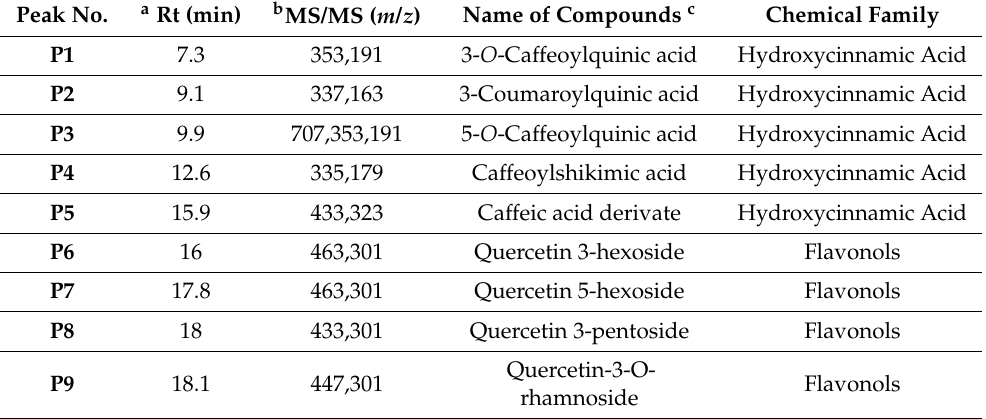
Table 5. Phenolic compounds (non-anthocyanin) identified by HPLC-DAD-ESI-MS n in Mortiño berries. Peak No.